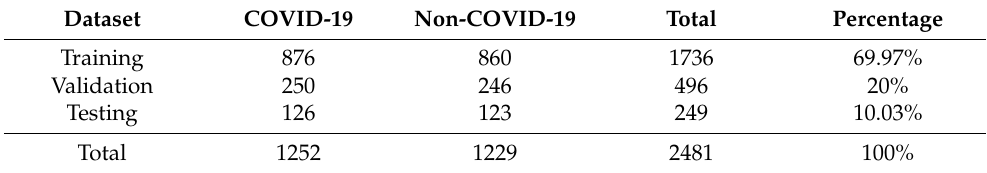
Table 1. Dataset